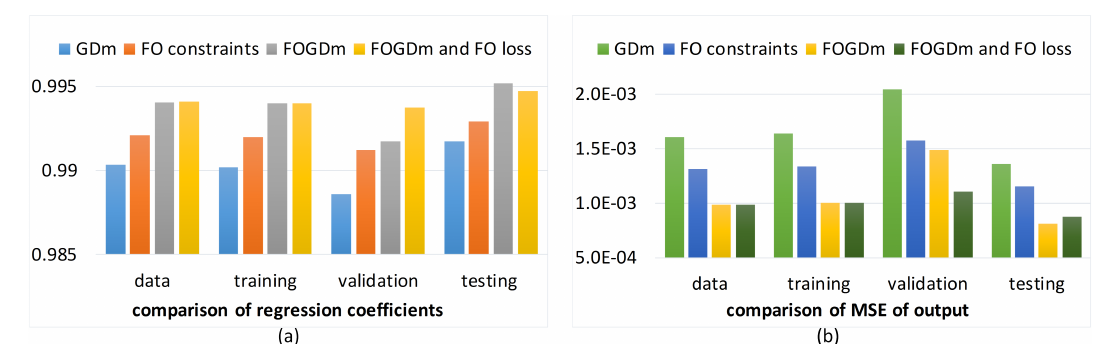
Figure 13. Comparison of output performance of four NN algorithms (marked as “GDm”, “FO constraints”, “FOGDm”, and “FOGDm and FO loss”). ( a ) Regression coefficient and ( b ) MSE of